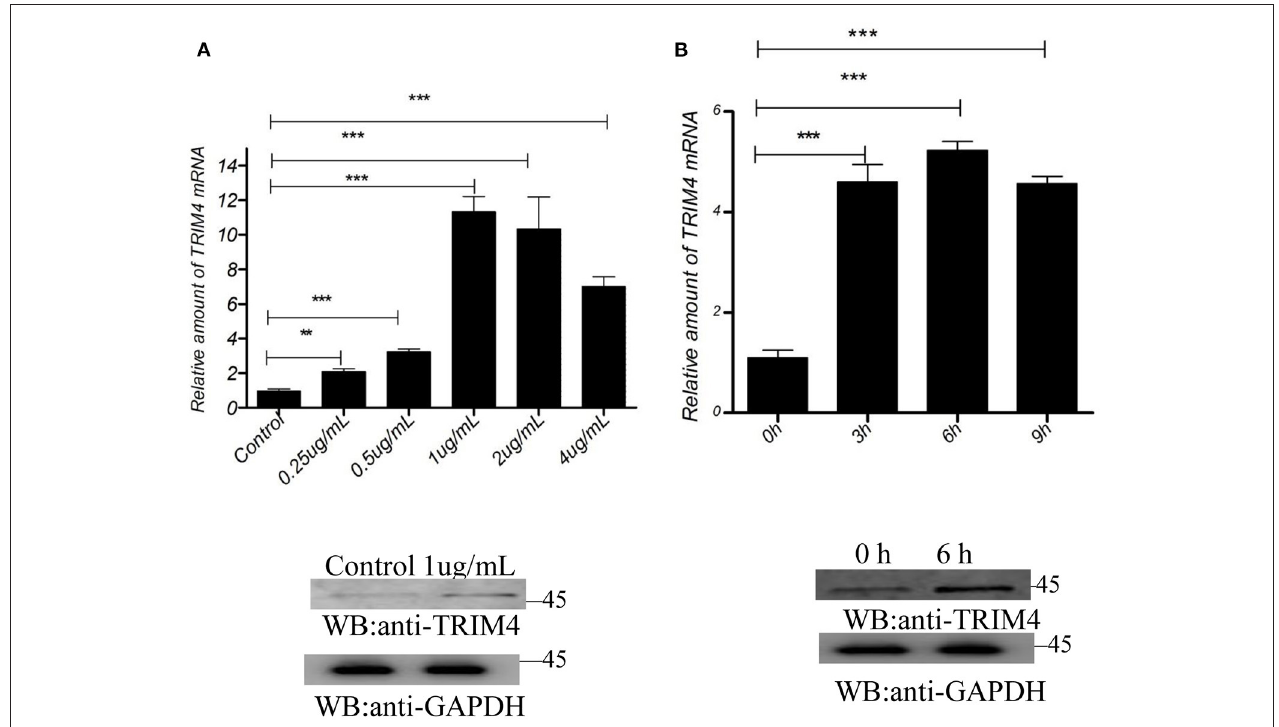
FIGURE 3 | Poly(I:C) response to TRIM4 expression. (A) Effect of different poly(I:C) concentrations on TRIM4 expression. MARC145 cells were transfected with poly(I:C) at different doses (0, 0.25, 0.5, 1, 2, and 4 µ g/mL). After 9h, the cells were collected, and the changes in TRIM4 were determined by qPCR and western blotting. (B) Evaluation of different time points at the same poly(I:C) concentration on TRIM4 expression. Poly(I:C) (1.0 µ g/mL) was transfected into MARC145 cells. The mRNA level and protein level of TRIM4 was tested by qPCR and western blotting at the designated time points (0, 3, 6, and 9h). ** P < 0.01; *** P <